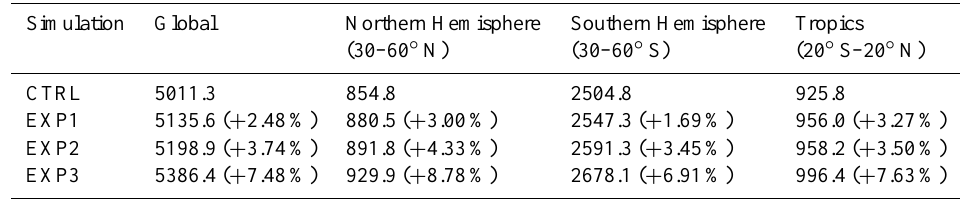
Table 2. Simulated annual mean global and regional sea salt emissions (Tgyr − 1 ) for the year 2006. Numbers in parenthesis are the relative differences with respect to the default model (CTRL). Meanings of the simulation short names are explained in Table 1. NOSG and EXP4 are not included here because they are identical to CTRL and EXP3, respectively, in terms of the sea salt emission parameterization.